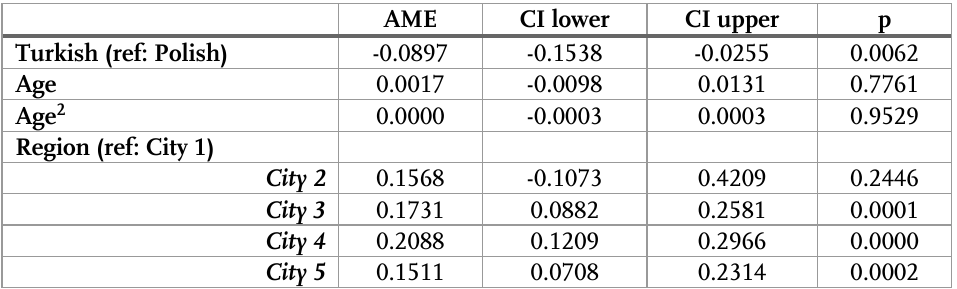
Baseline model (DV: Labour force participation) AME CI lower CI upper p Turkish (ref: Polish)